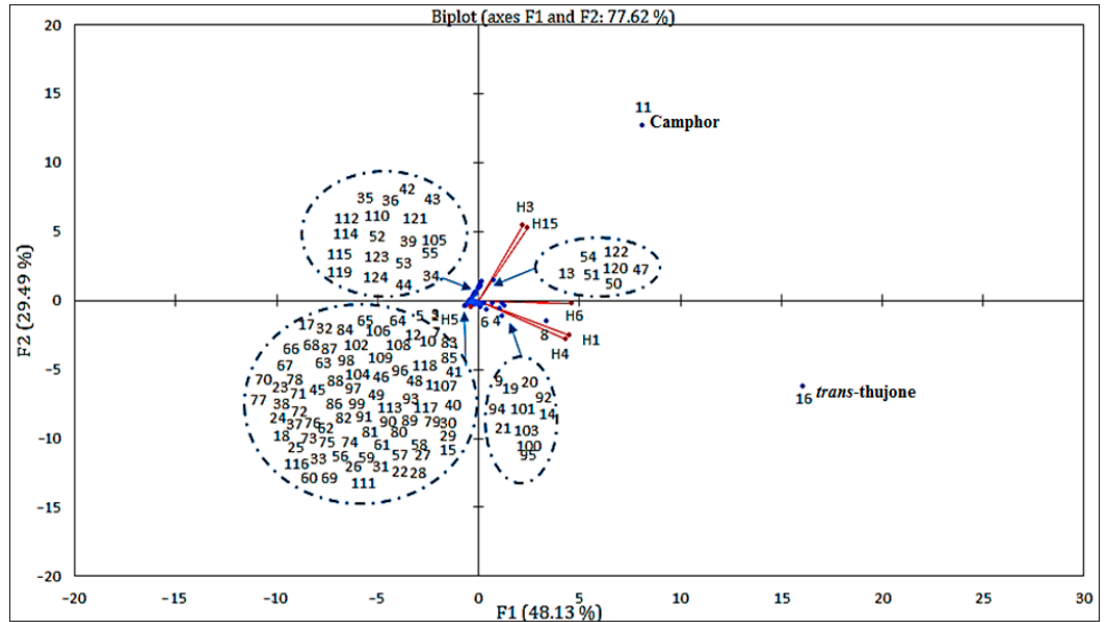
Figure 5. Correlation between the principal compounds and the essential oils of the six samples from different regions